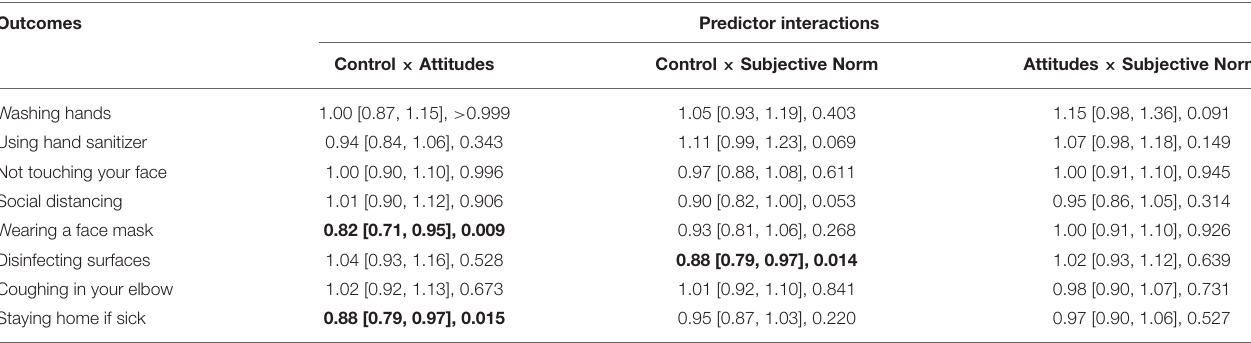
TABLE 4 | Interactions between perceived behavioral control, attitudes, and subjective norm predicting preventive behaviors.